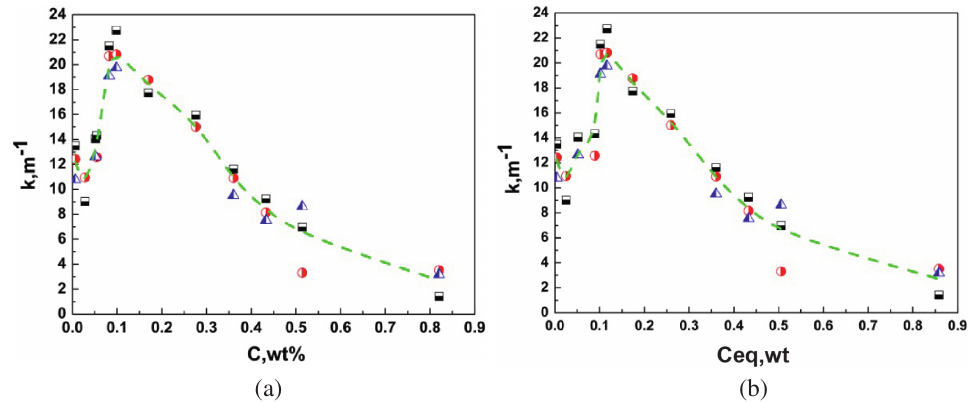
Figure 12: Effect of carbon content on the deformation degree of the solidified shell, (a) actual carbon content (w[C]%); (b) carbon equivalent content (Ceq).